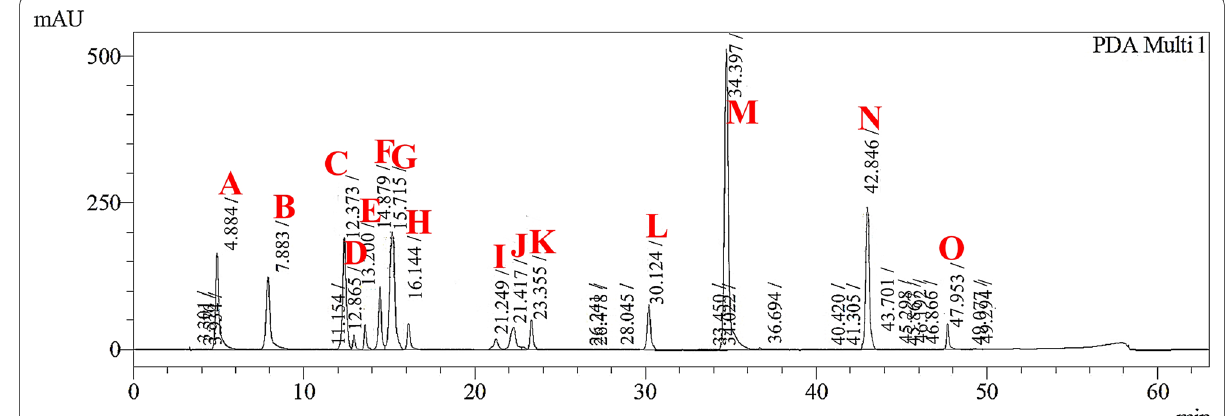
Fig. 2 Chromatogram representing mixture of 15 standards under study. Gallic acid ( A ), protocatechuic acid ( B ), Catechin ( C ), o-hydroxybenzoic acid ( D ), chlorogenic acid ( E ), vanillic acid ( F ), syringic acid ( G ), caffeic acid ( H ), m-hydroxybenzoic acid ( I ), p-coumaric acid ( J ), sinapic acid ( K ), t-ferulic acid ( L ), t-cinnamic acid ( M ), biochanin A ( N ) and anthrol ( O